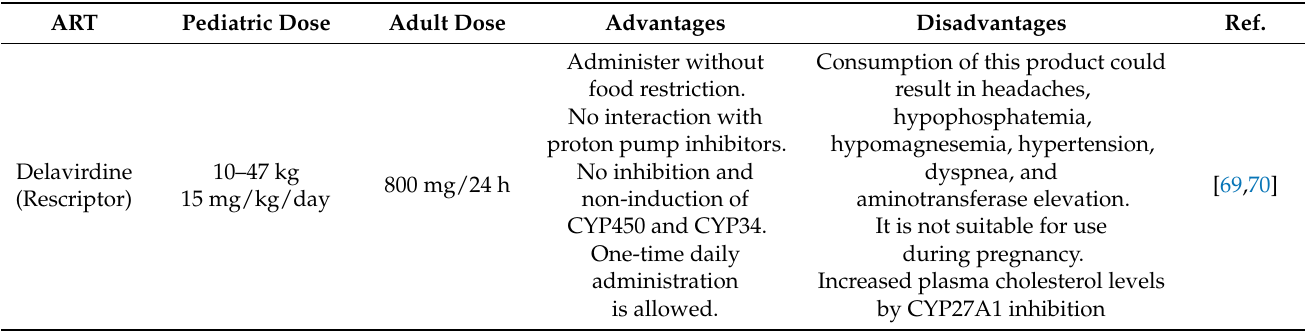
Table 3. Non-nucleoside reverse transcriptase inhibitors